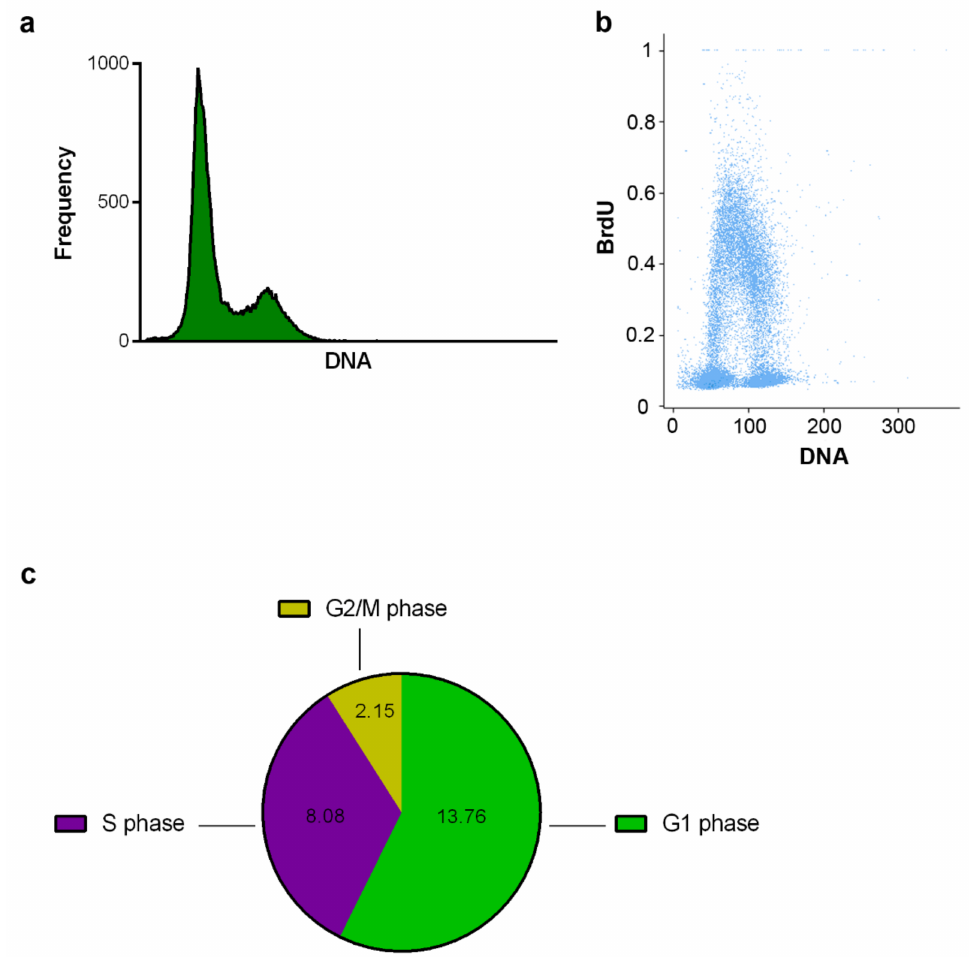
Figure 7. Cell cycle analysis. HeLa S3 cells were labeled with BrdU and captured on glass coverslips. The samples were evaluated by image cytometry after the immunostaining of BrdU and staining of DNA by DAPI. The DNA histogram ( a ), the bivariate plot of the DNA and BrdU signal ( b ) and the estimated length of the particular phases of the cell cycle in hours ( c ) are